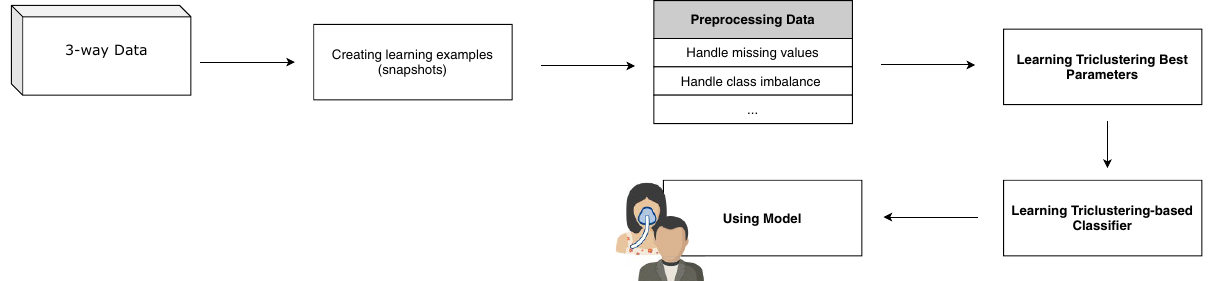
Figure 1. Proposed Workflow to Learn a Triclustering-based